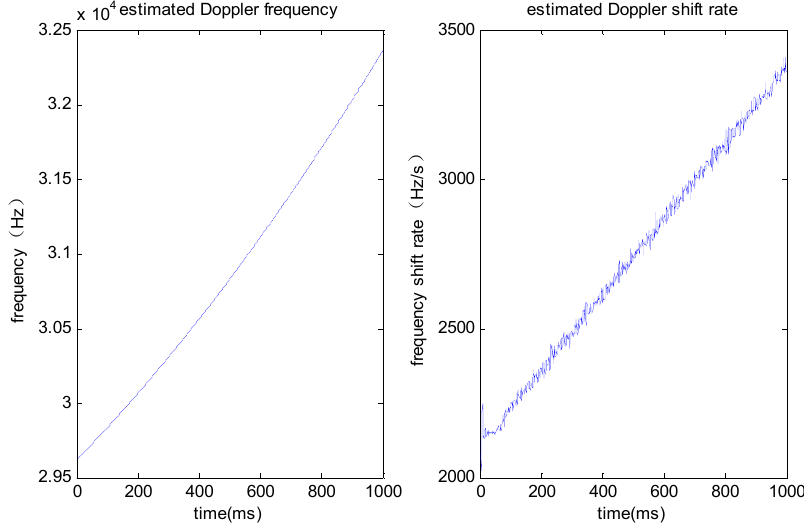
Figure 6. Estimated Doppler frequency and Doppler shift rate with jerk aided